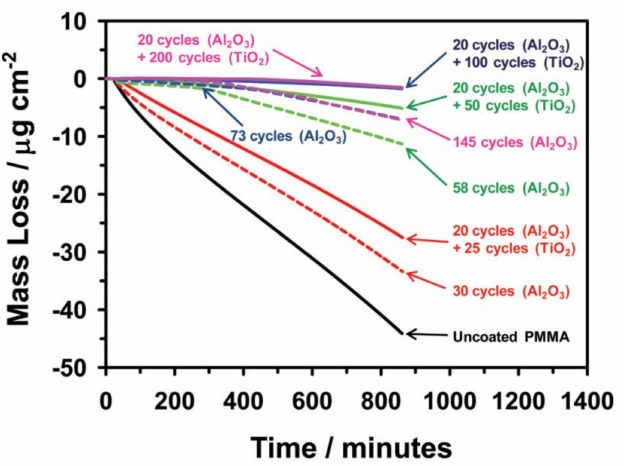
Figure 14. Mass loss of uncoated and coated PMMA with Al 2 O 3 and Al 2 O 3 /TiO 2 when exposed to vacuum UV radiation over time (reprinted with permission from [65], Copyright (2010) American Chemical